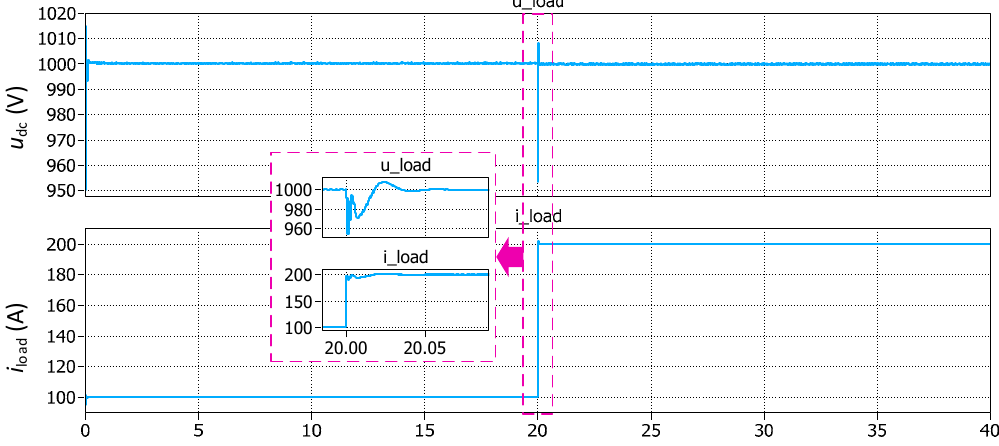
Figure 12. The DC bus voltage and load current in hybrid mode.